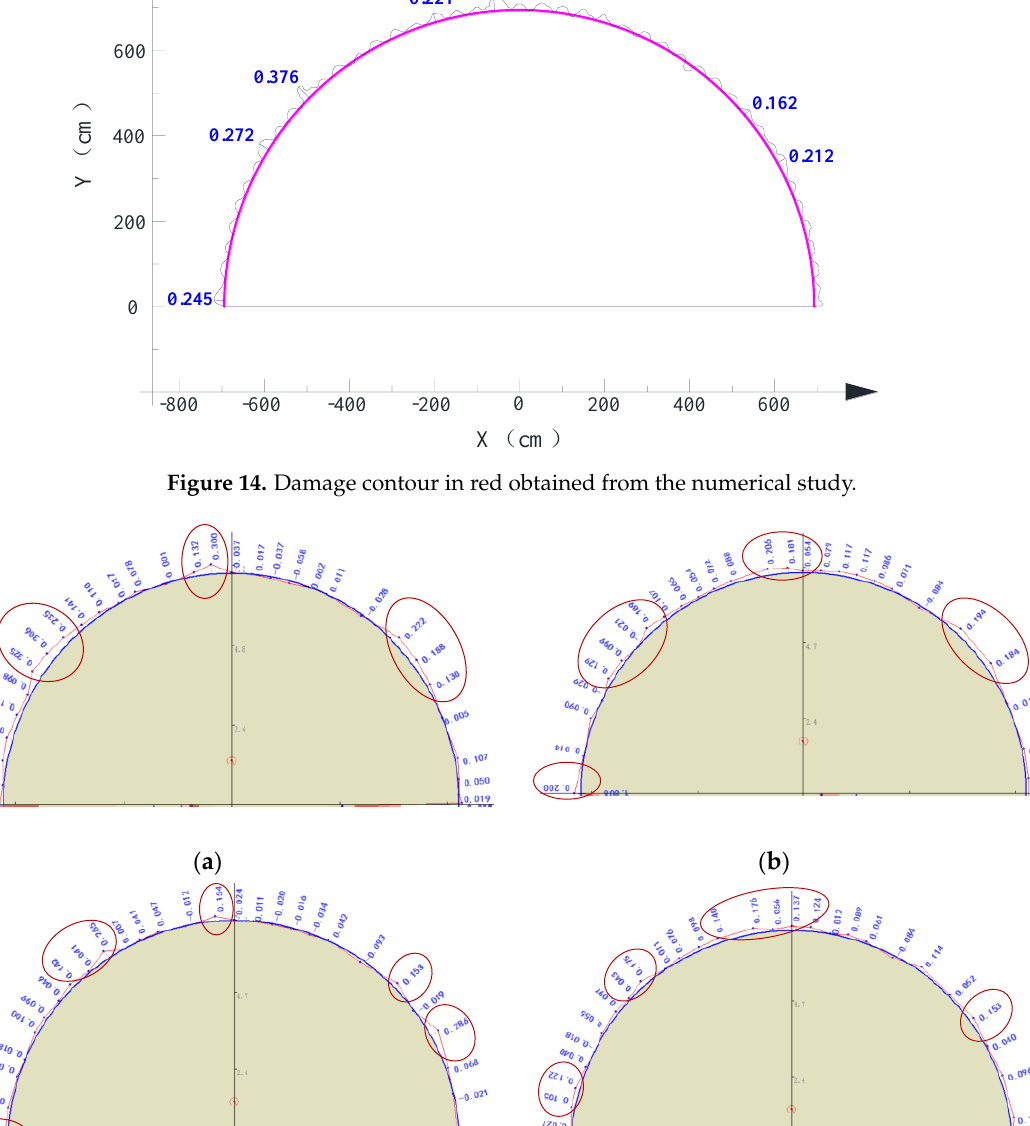
Figure 13. Damage contour in blue obtained from the numerical study.